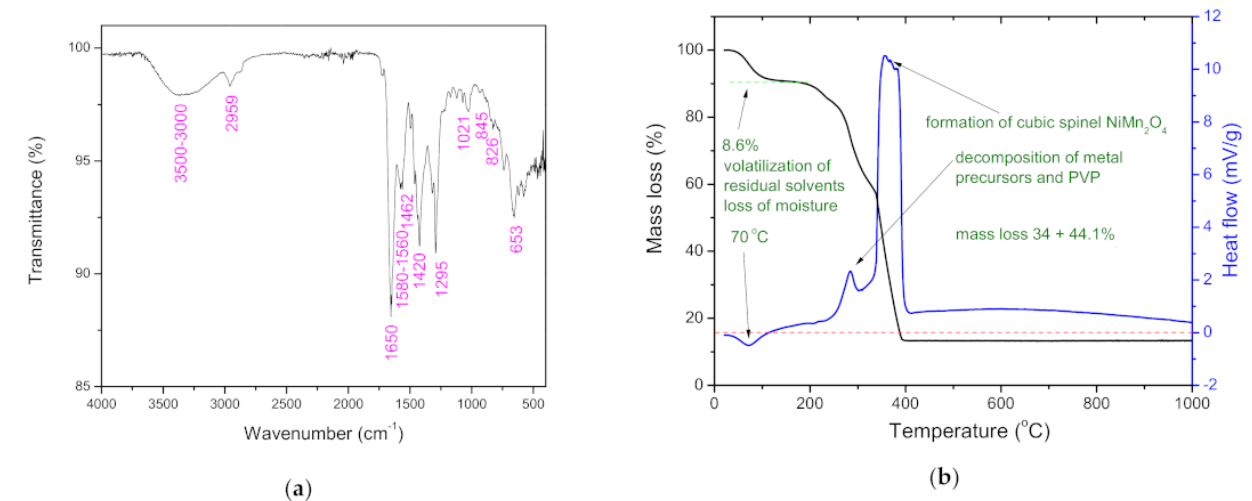
Figure 2. FT-IR spectrum ( a ) and TG/DTA plots ( b ) measured on as-spun fibers. The measured TG/DTA in Figure 2b shows the thermal behavior of the as-spun fibers. The total mass loss was ≈ 86.7% up to 400 ◦ C, after which it remained constant in the temperature region 400–1000 ◦ C. The mass loss can be divided into three regions in accordance with Bhagwan et al. [31] who determined the same for electrospun nickel manganite fibers. It started with volatilization of the residual solvents present in fibers (DMF, ethanol) and loss of moisture/desorption of water (H 2 O) [36] corresponding to the initial minor mass loss of ≈ 8.6% from ≈ 20 to 113 ◦ C, and endothermic peak at ≈ 70 ◦ C. A small exothermic peak at ≈ 284 ◦ C, followed by a distinct wide exothermic peak with a maximum at ≈ 357 ◦ C can be noted, accompanied by a weight loss of 34 and 44.1%, respectively. Both peaks may be ascribed to decomposition of the metal precursors and PVP in the electrospun fibers, but the second can be ascribed to complete decomposition and removal of PVP and formation of the cubic spinel structure